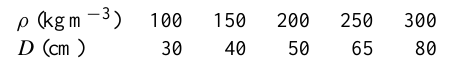
Table 4. Average slab thickness as a function of slab density for PST field